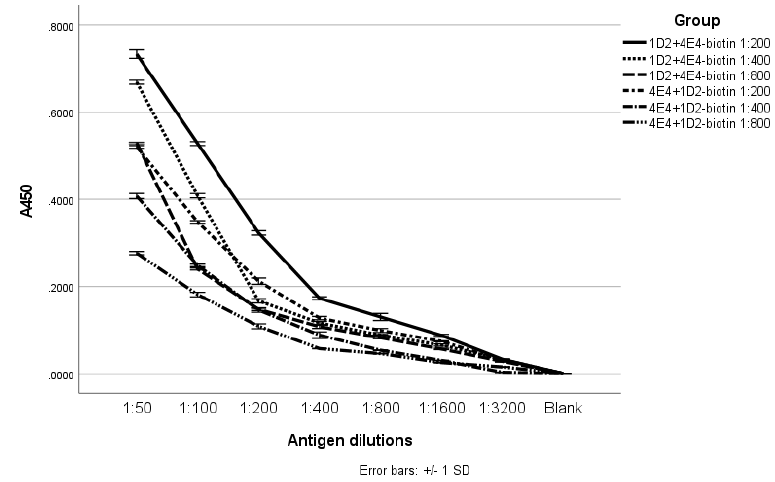
Figure 6. Sandwich ELISA optimization. The combination of 1D2 (5 μ g/mL) as the capture antibody and 4E4-biotin (5 µ g/mL) as the detection antibody showed the best absorbance with the various cell wall antigen concentrations (solid line).